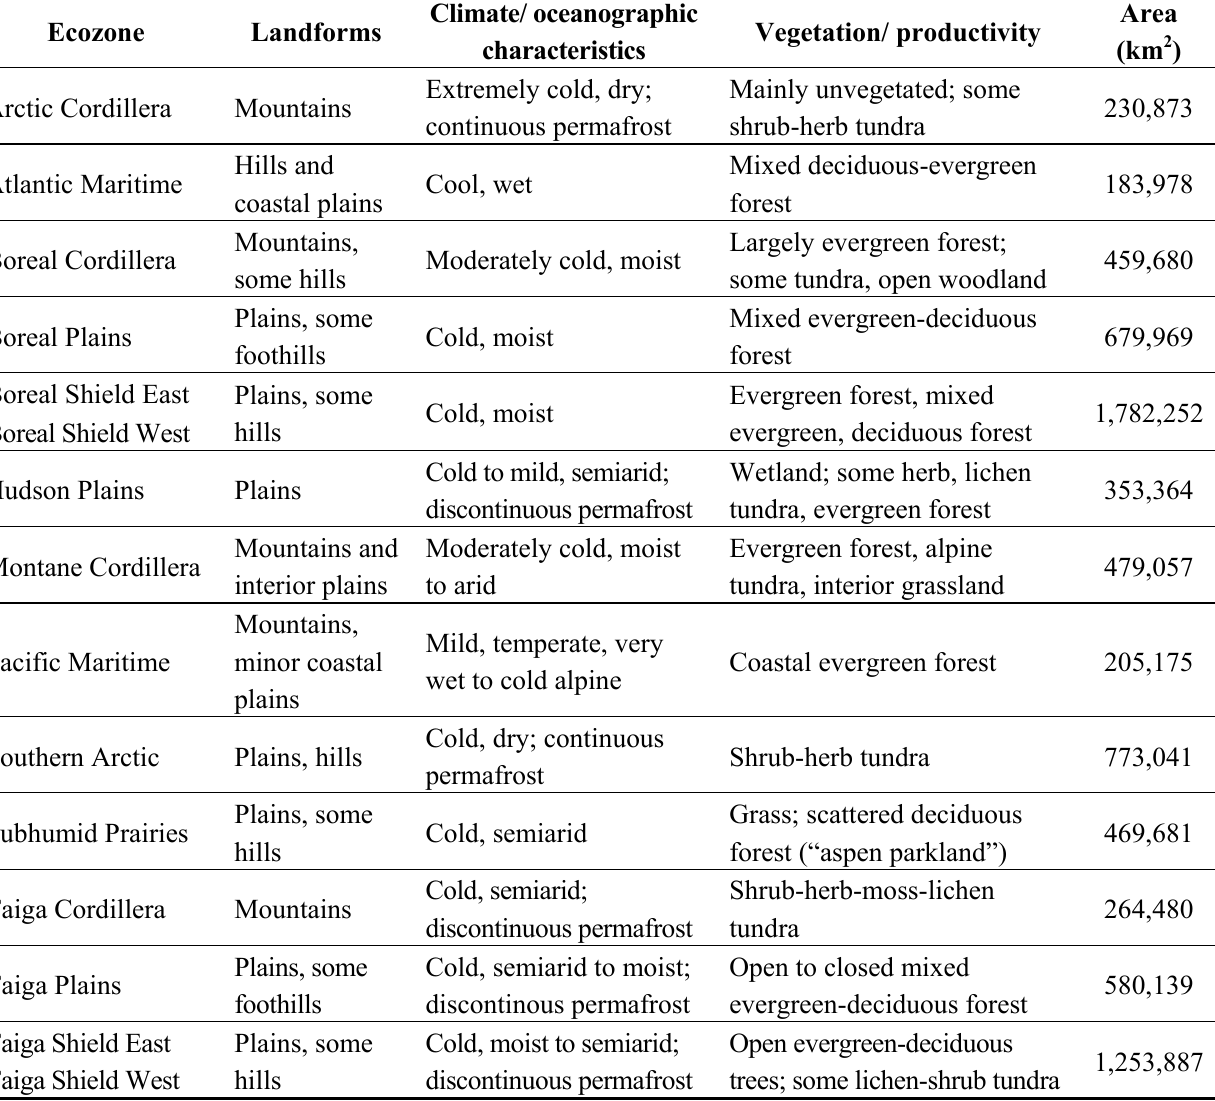
Table 1. Ecozone descriptions for Canada’s